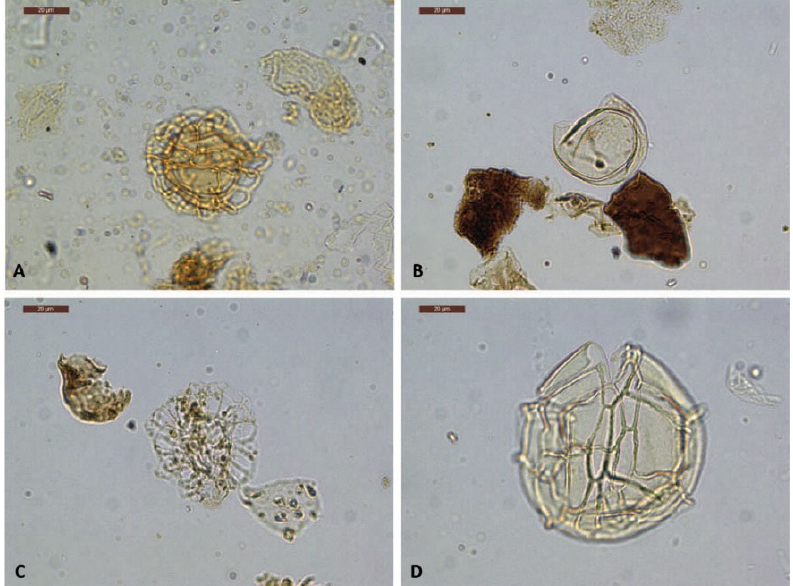
Figure 14. Middle Miocene dinoflagellates typical for the open marine conditions: ( A ) Unipontidinium aquaeductus (Piasecki, 1980) Wrenn, 1988, locality Laz Stubi č ki (position 1 at Figure 3); ( B ) Batiacasphaera sphaerica Stover, 1977; ( C ) Nematosphaeropsis labyrinthus (Ostenfeld, 1903) Reid, 1974; ( D ) Impagidinium patulum (Wall, 1967) Stover and Evitt, locality Kostajnica (position 4 at Figure 3). Scale bars: 20 μ m.